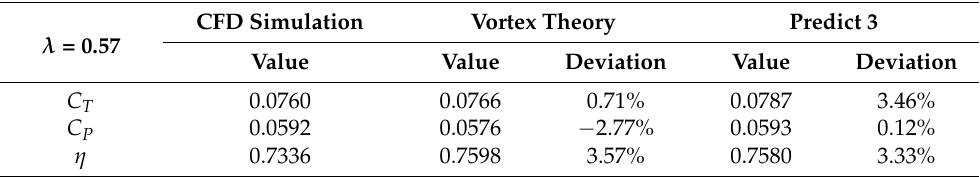
Table 4. Comparison of predicted value and simulate value at design